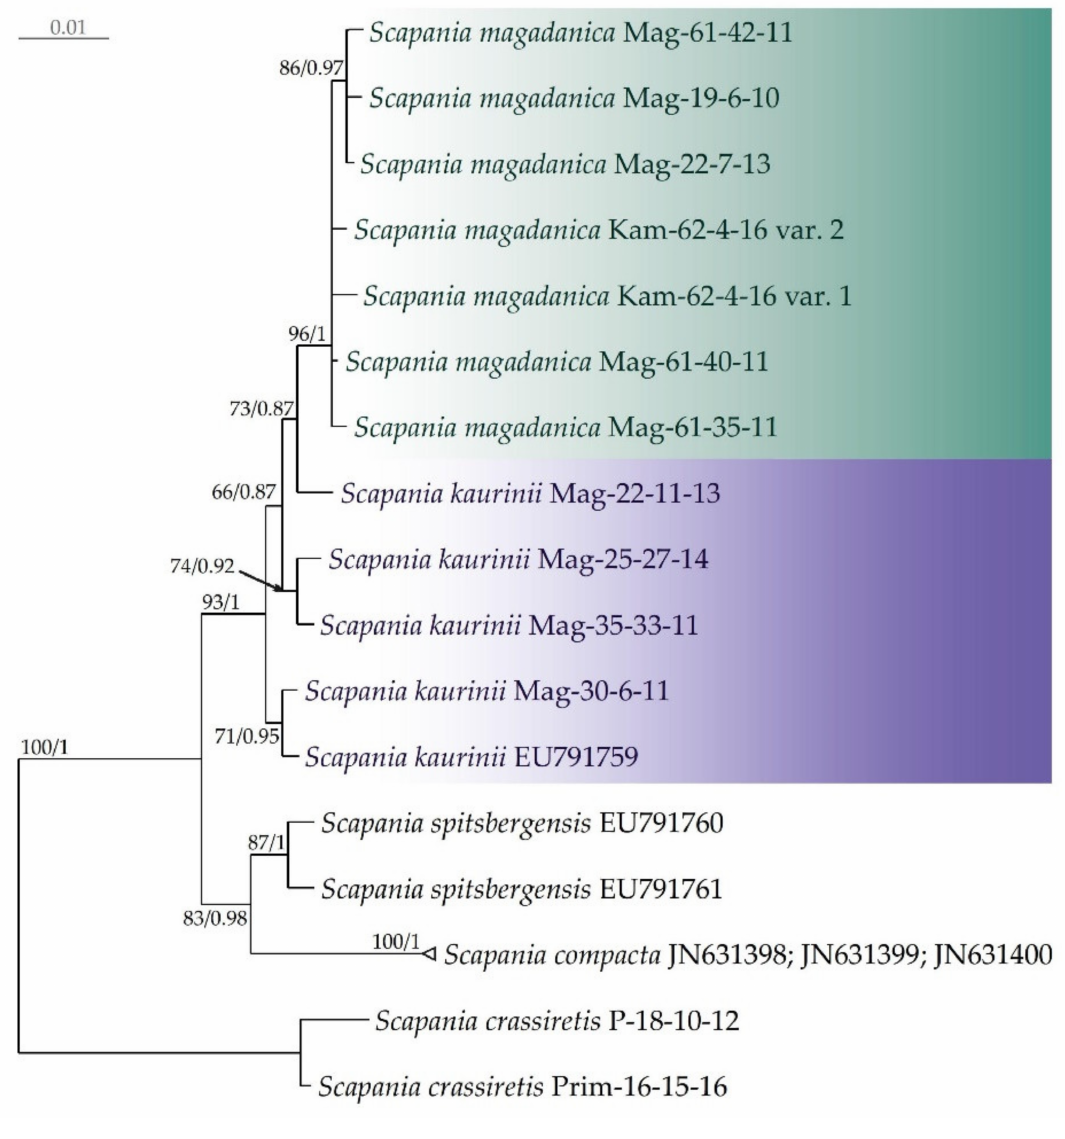
Figure 1. Phylogram obtained in a Bayesian analysis for the Scapania magadanica and S. kaurinii taxa based on the ITS1–2 dataset. The values of bootstrap support from the ML analysis and Bayesian posterior probabilities greater than 0.50 (50%) are indicated. Three sequences of S. compacta from GenBank were identical, so we combined them. Taxon names, vouchers, and GenBank accession numbers are